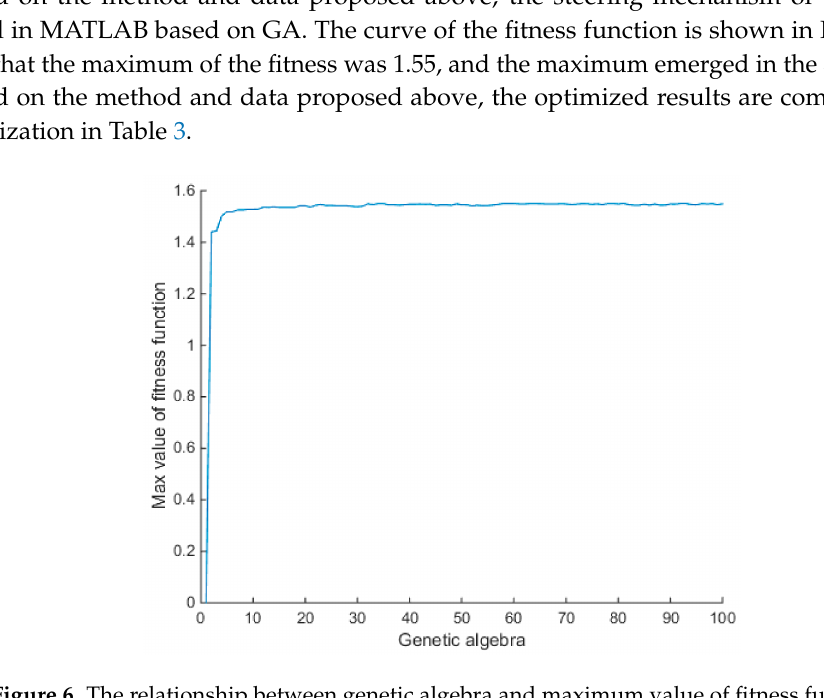
Figure 6. The relationship between genetic algebra and maximum value of fitness function. Table 3. Data comparison between before and after